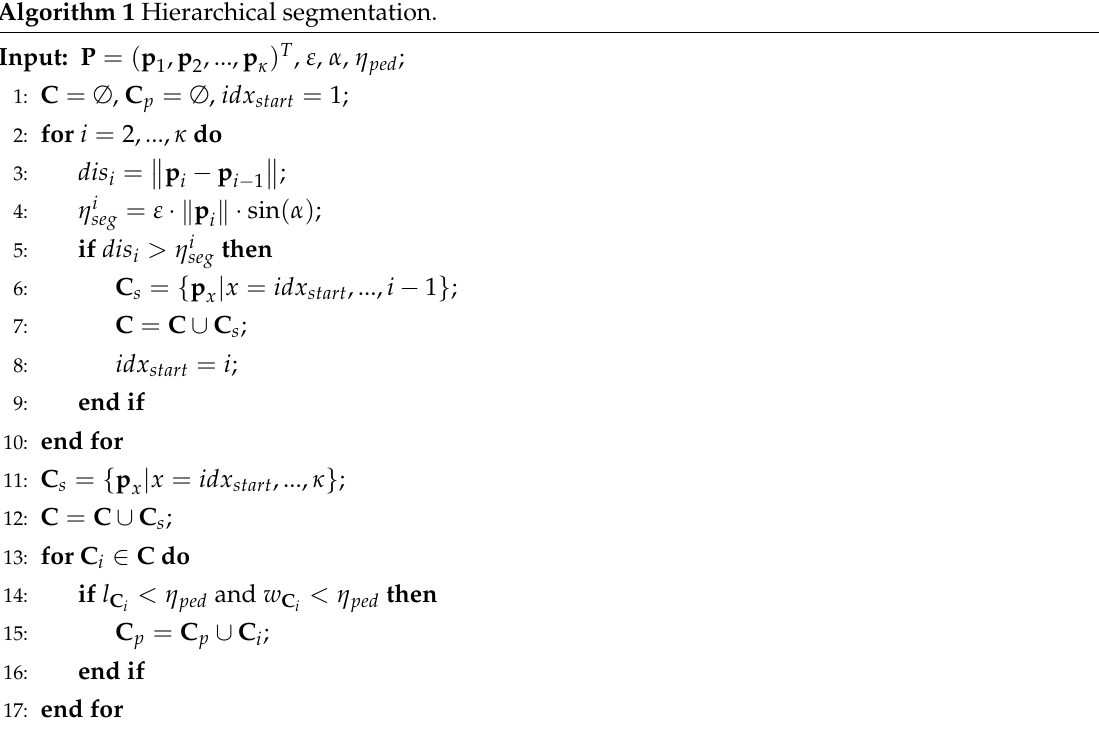
Algorithm 1 Hierarchical